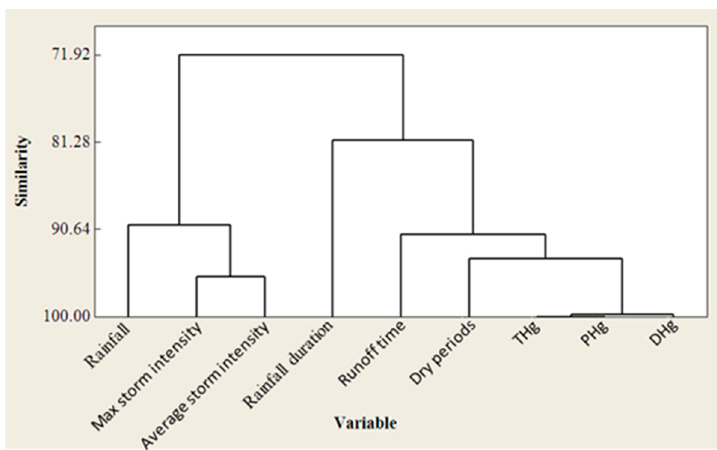
Figure 4. Cluster analysis of different Hg species and characteristics of rainfalls.